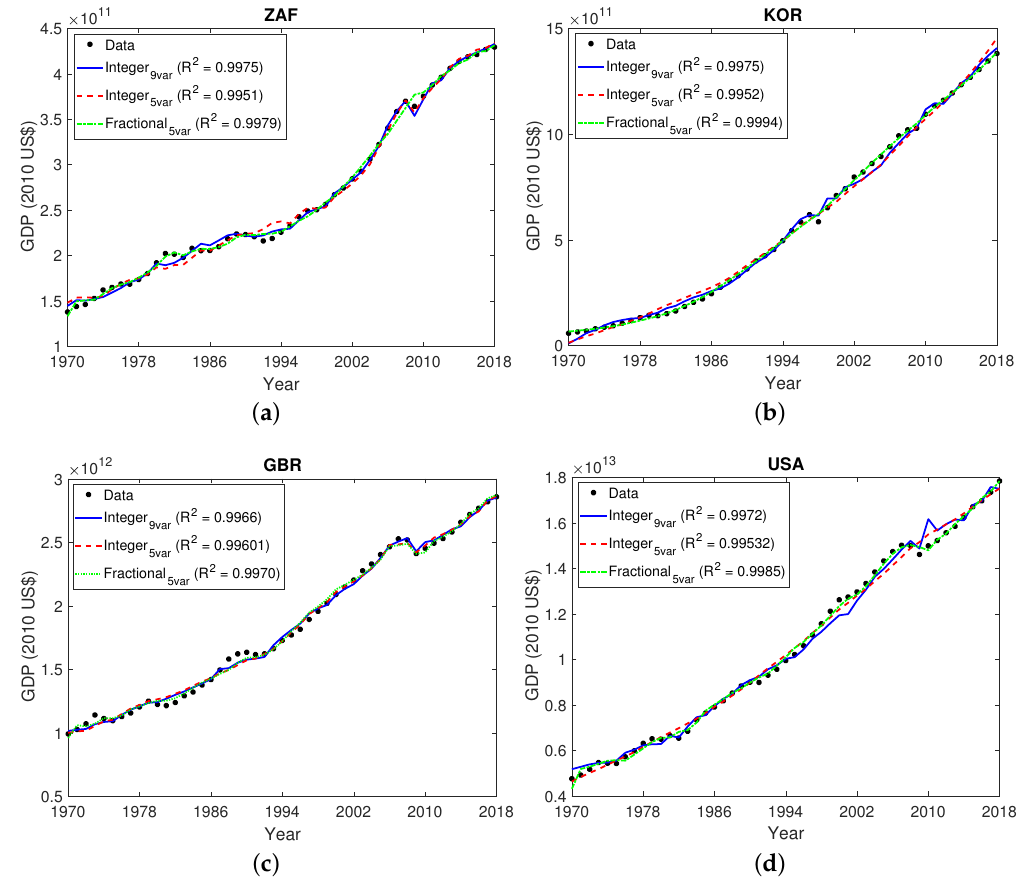
Figure 4. Results obtained with integer and fractional models for the following members of the G20: ( a ) South Africa ( b ) Korea ( c ) United Kingdom ( d ) United States of America. GDP estimations were obtained with integer models (1) and (2) and with fractional model (3). R 2 values are given to show the quality of the results of each model. As GDPs have different orders of magnitude, different scales were used in the y -axis for different